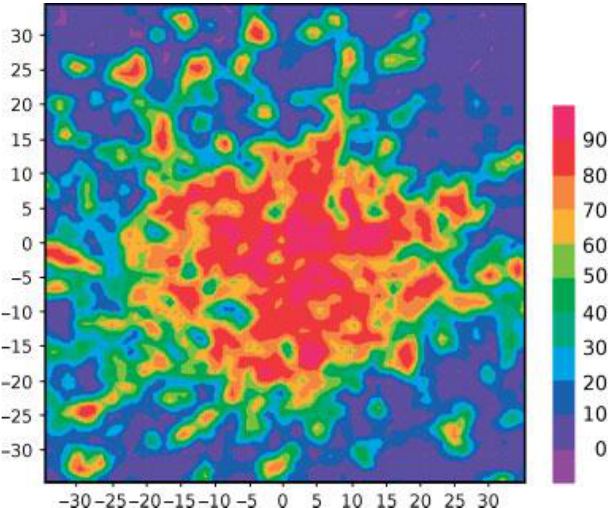
Figure 4. Image showing the percentage of land covered by either continuous urban (red) or continuous rural (blue) in the 40 × 40 km domain north of Qinzhou, Guangxi and lying between highways G75 and G325.